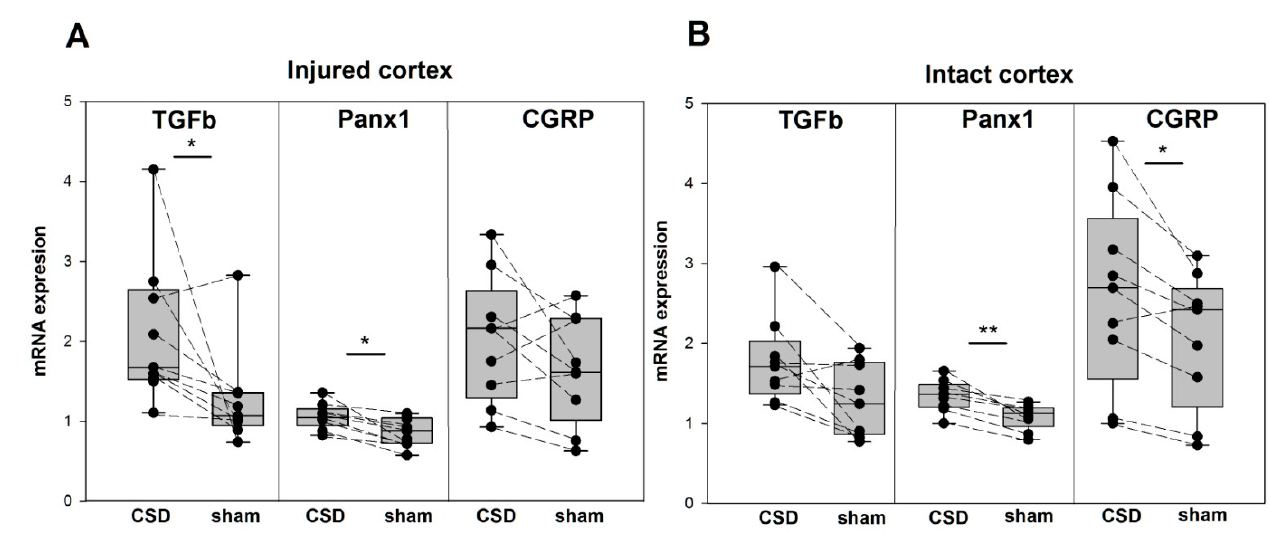
Figure 4. Expression of TGFb, Panx1, and CGRP following a single CSD in the injured and intact regions of the cerebral cortex. Levels of TGFb, Panx1, and CGRP mRNA (medians with interquartile ranges and individual data from each rat, n = 9) in the perilesional tissue of the somatosensory cortex ( A ) and in the intact tissue of the frontal cortex ( B ) of the lesioned (CSD) and opposite (sham) hemisphere. * p < 0.017 and ** p < 0.0085—ipsilesional versus sham-treated cortical regions (post hoc Wilcoxon test with Bonferroni correction).